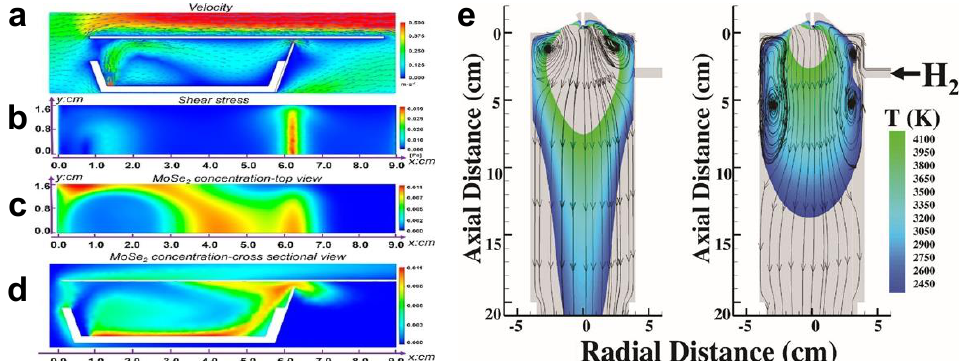
Figure 21. At t = 0.4 s, ( a ) velocity distribution and velocity vectors and ( b ) shear stress distribution over the growth substrate. ( c ) Top-view snapshot of MoSe 2 concentration distribution. ( d ) Cross- section view of MoSe 2 concentration. ( e ) The temperature distribution cut-off between 2300 and 4200 K as the BNNT growth temperature range (left, without hydrogen; right, with